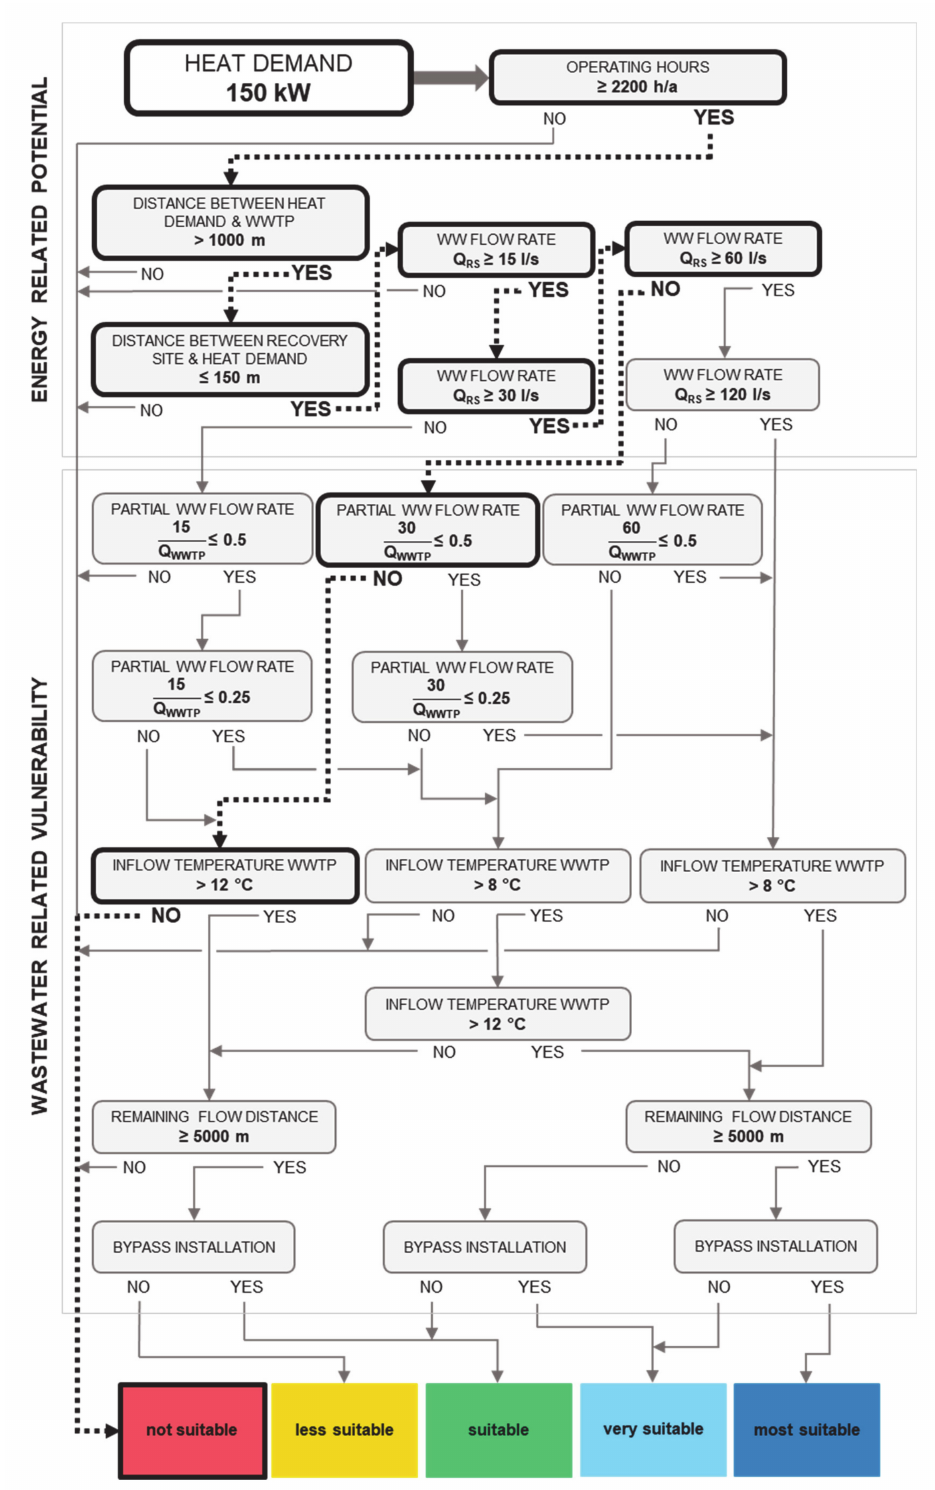
Figure 7. Pre-assessment process for heat recovery site M1 for an intended heat supply of 150 kW (own representation, based on